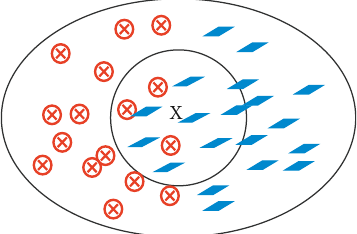
Figure 2: Example of uneven density. Figure 3. The specific steps are as follows: the input is sample Y � Y , Y , ..., Y 􏼈 􏼉 . to be tested, where l ∈ ( 1 , N ) . This N 1 2 study sets up an M-dimensional training sample set X � X , X , ..., X 􏼈 n 1 2